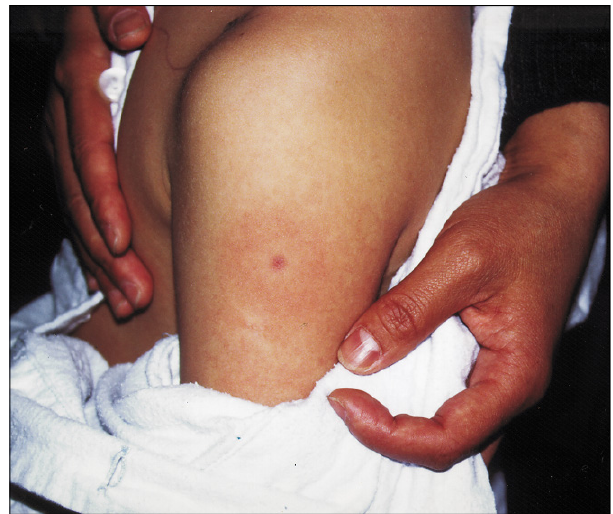
Fig ure 1) The site of pre vi ous ba cillus Calmette- Guérin vac ci na tion, as seen dur ing the child’s cur rent feb rile ill